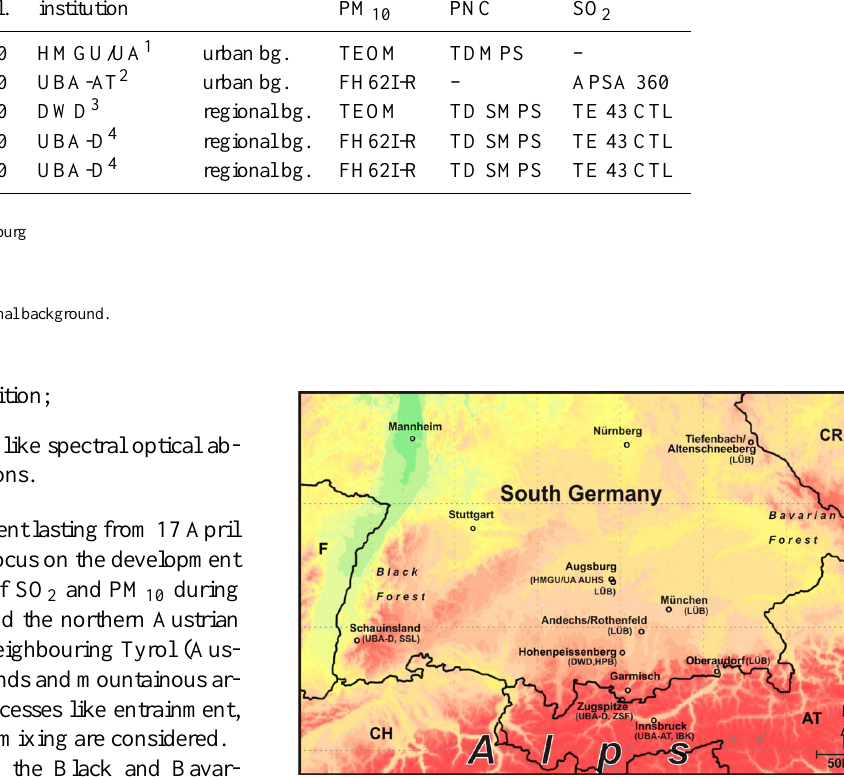
Table 1. All stations and in situ measurement methods used. station